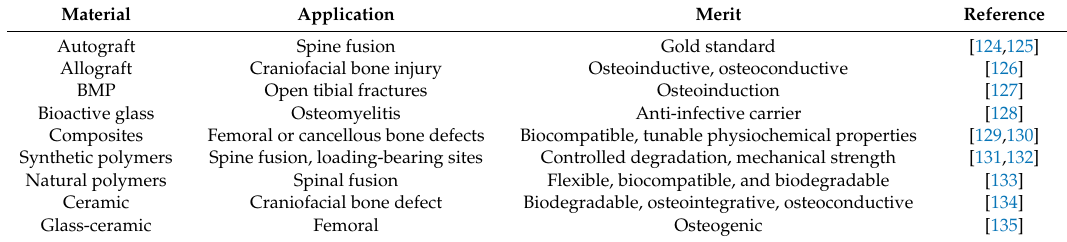
Table 1. The application of n-HAp sca ff olds in bone tissue engineering. BMP, bone morphogenetic protein.